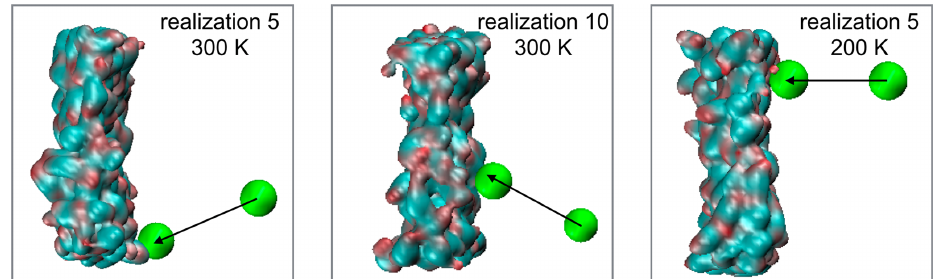
Figure A1. Snapshots showing the impact angle in randomly selected trajectories. The pulled molecule is shown as a green bead while the organic phase is represented by it solvent accessible surface. The aqueous phase was removed from the snapshot for clarity.